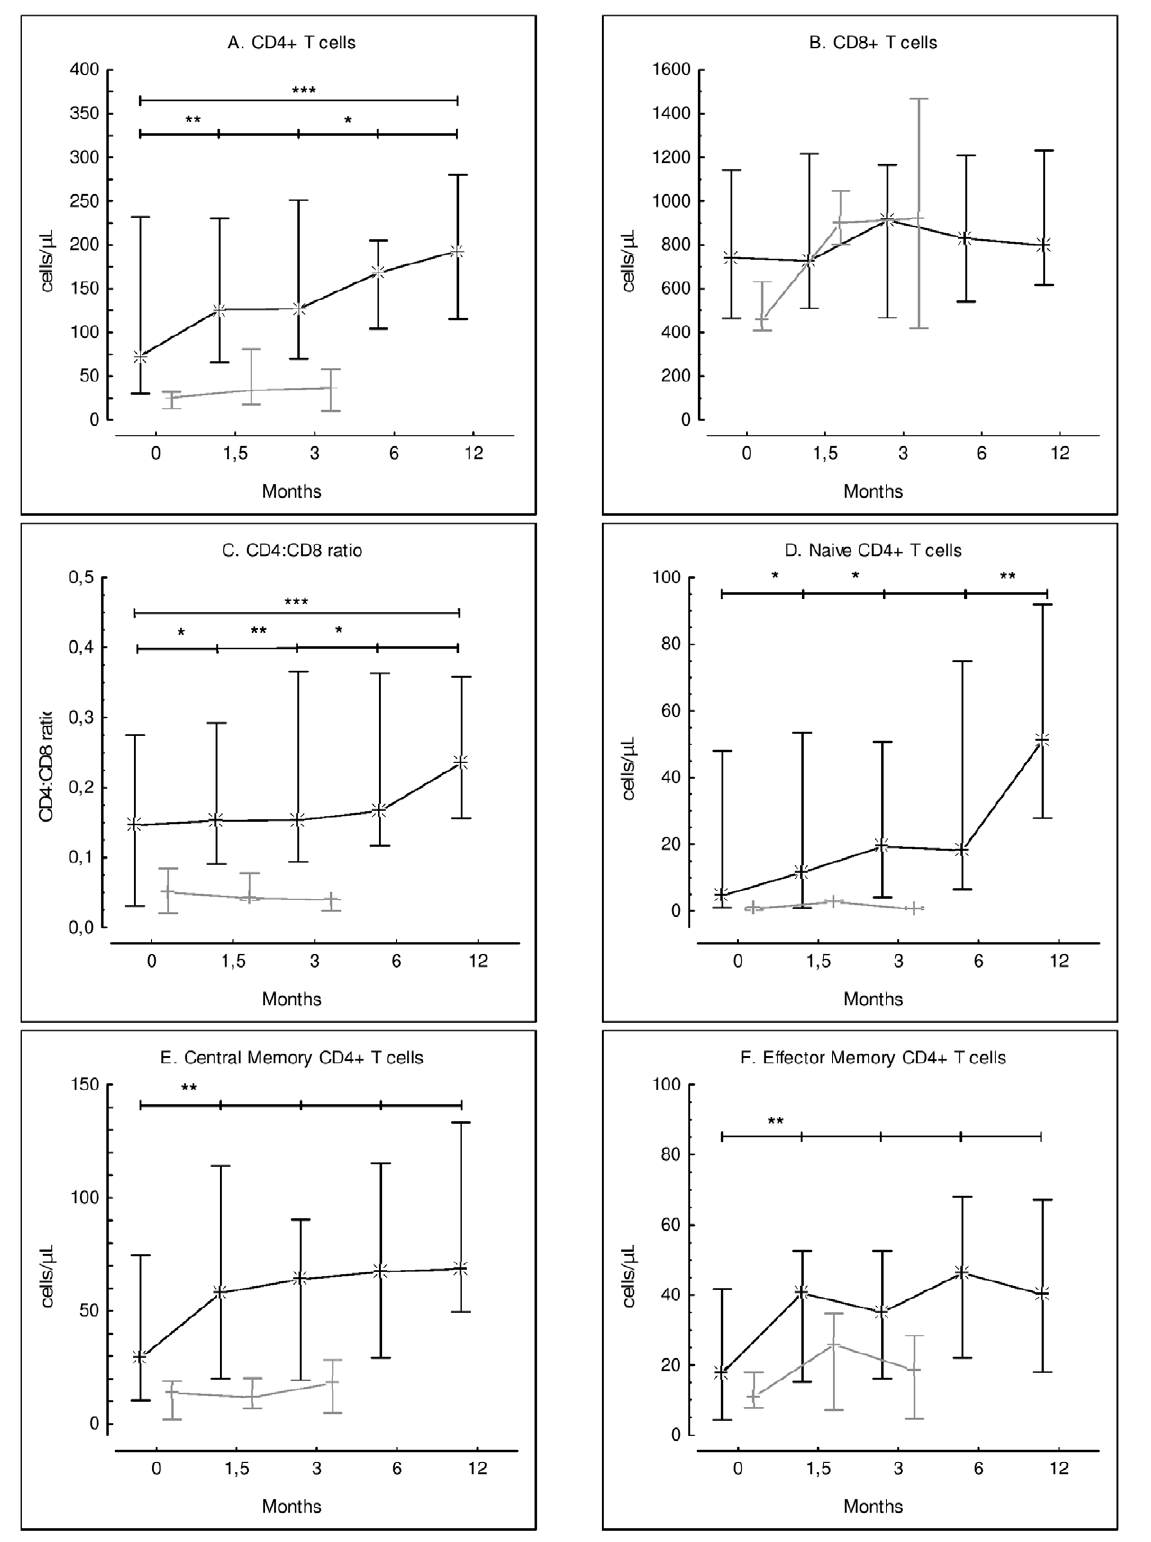
Figure 3. Time course of CD4 + and CD8 + T cell populations from baseline to month 12. Compared to baseline, significant increases were observed at W6 and at each subsequent time point in: the CD4 + T cell count (panel A); the CD4:CD8 ratio (panel C); naive CD4 + T cells (panel D); central memory CD4 + T cells (panel E); and effector memory CD4 + T cells (panel F). No significant variation in the CD8 + T cell count (panel B) was noted during follow-up. (naive=CD45RA + CD62L + , central memory=CD45RA 2 CD62L + ), effector memory=CD45RA 2 CD62L 2 ). Whiskers represent medians and interquartiles. Black lines represent survivors and grey lines patients who died. Wilcoxon’s signed-rank test : * P , 0.05, ** P , 0.01, *** P , 0.001. doi:10.1371/journal.pone.0020967.g003 PLoS ONE |